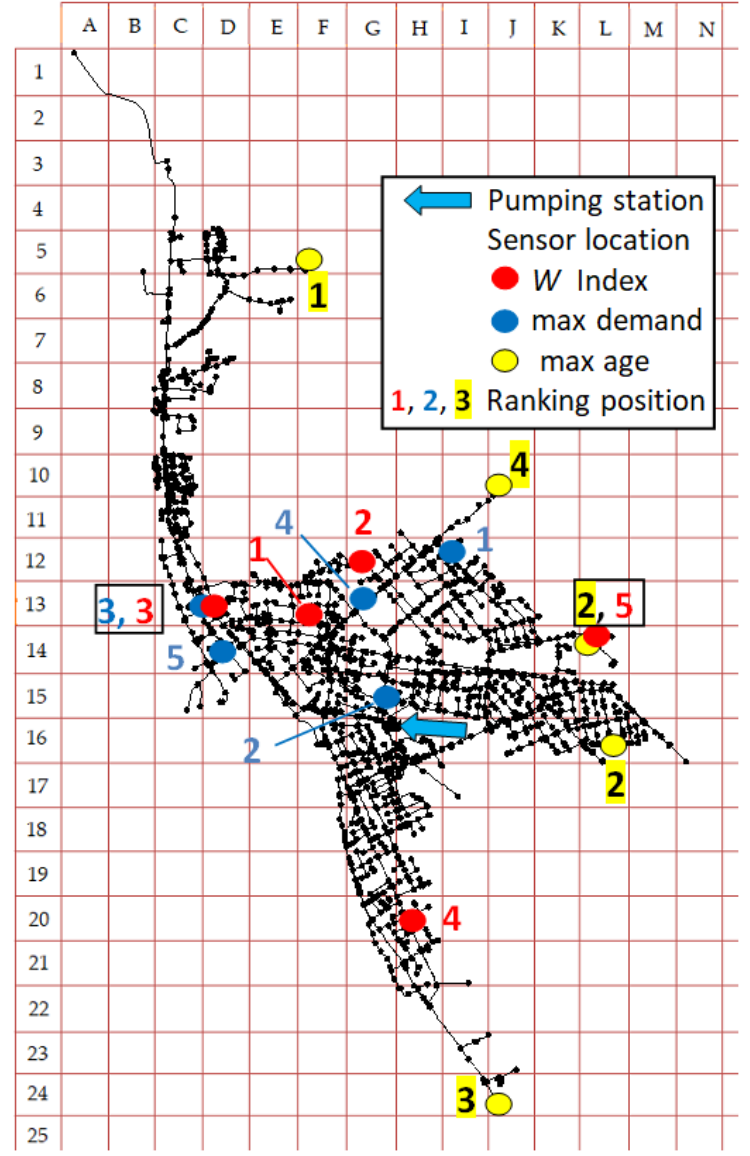
Figure 4. Sensor locations indicated using the proposed ranking method based on index W (red color), maximum water demand (blue), and maximum water age (yellow).